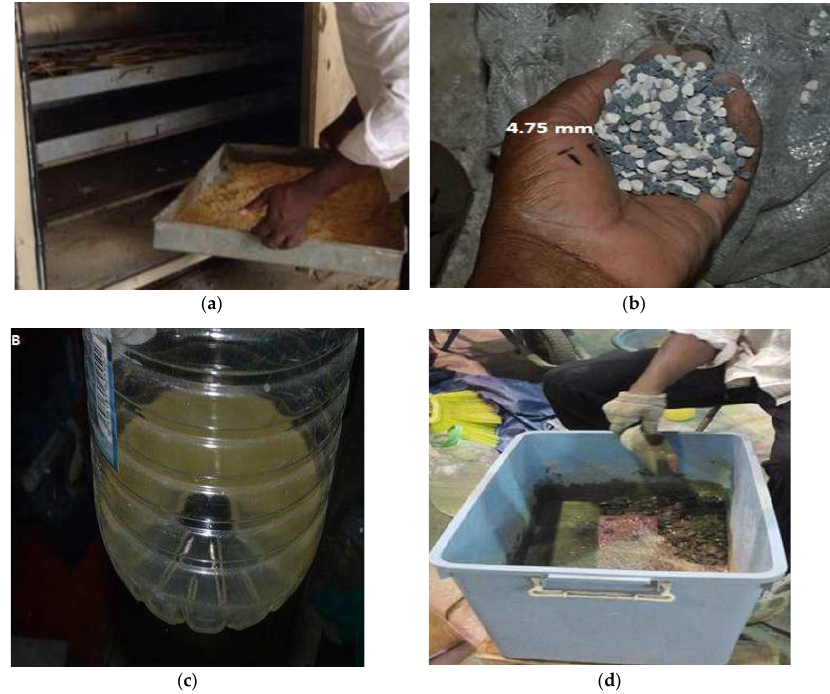
Figure 2. Illustrations of the concrete materials: ( a ) fine aggregate in the oven; ( b ) coarse aggregate; ( c ) Glenium ACE 388; ( d ) mixing process. Table 1. The proportions of concrete materials.